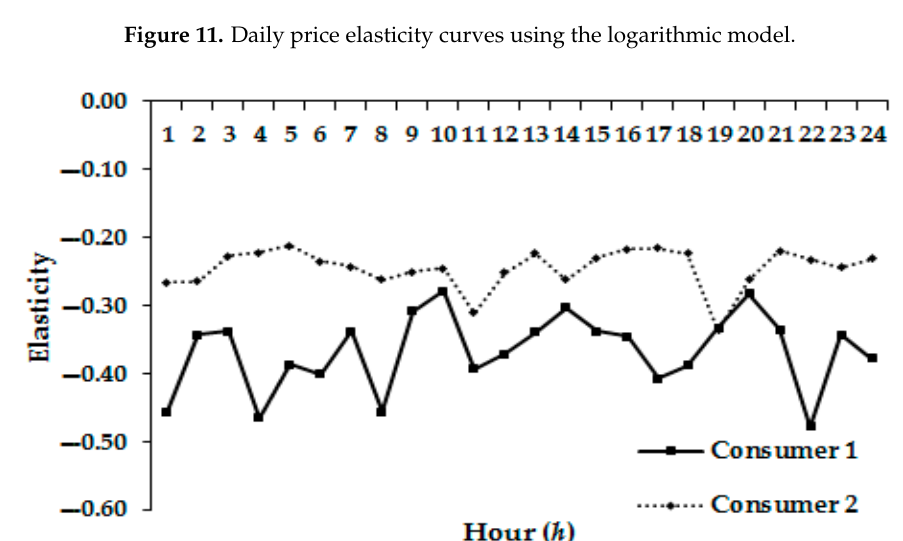
Figure 12. Daily price elasticity curves using the exponential model.